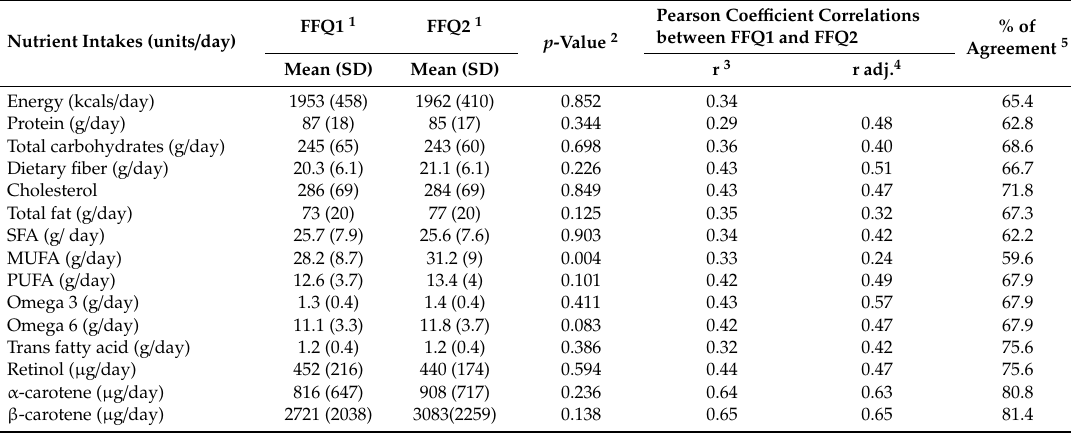
Table 3. Mean daily nutrient intakes and Pearson correlation coe ffi cients in two FFQs in children aged 7–9 years of the INMA-Valencia study ( n = 156). Nutrient Intakes (units / day)